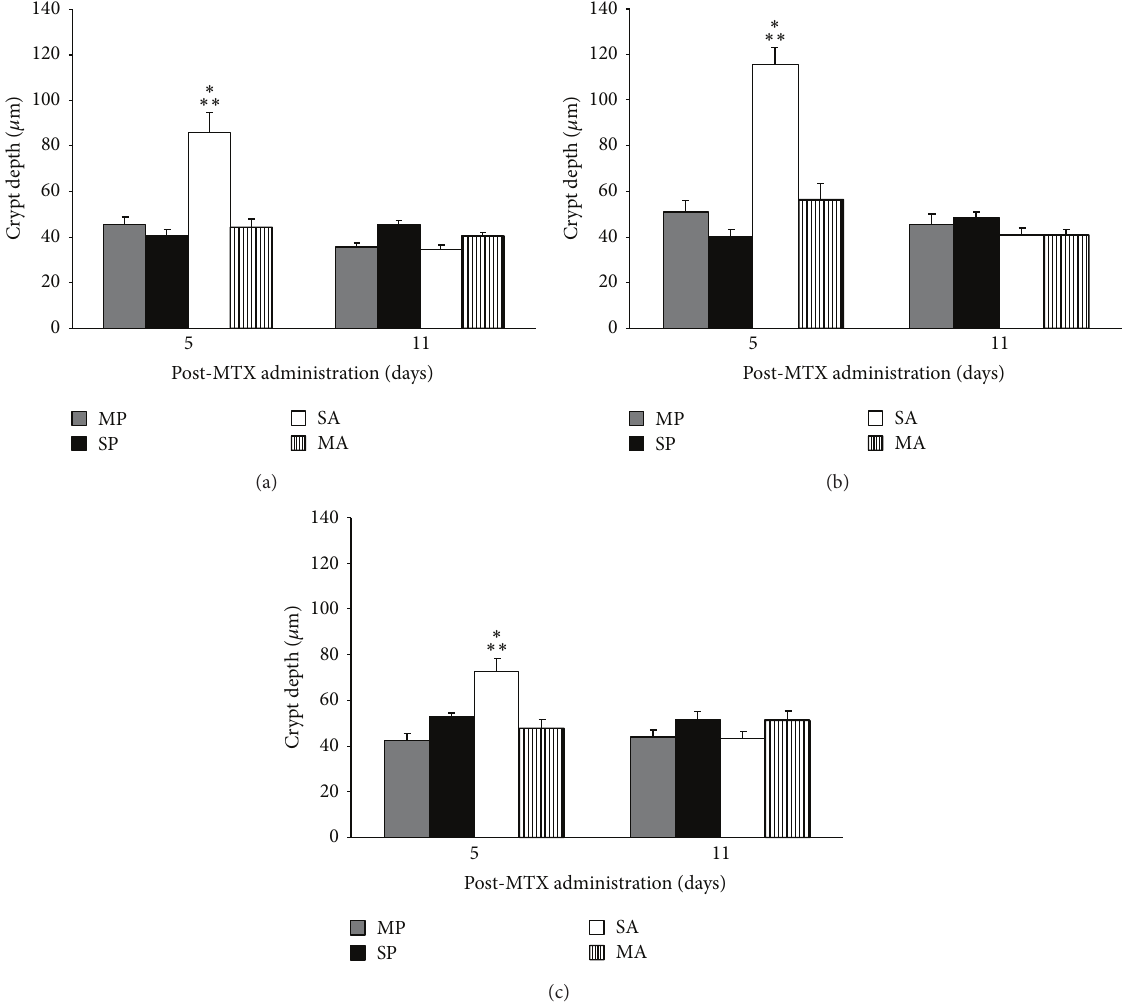
Figure 5: Crypt depth ( 𝜇 m) in the duodenum (a), jejunum (b), and ileum (c) of C57BL/6 mice treated with PS, PM, AS, and MA. ∗ denotes significant difference ( 𝑃 < 0.01 ) compared to all other groups within d 5. ∗∗ denotes significant difference ( 𝑃 < 0.01 ) compared to d